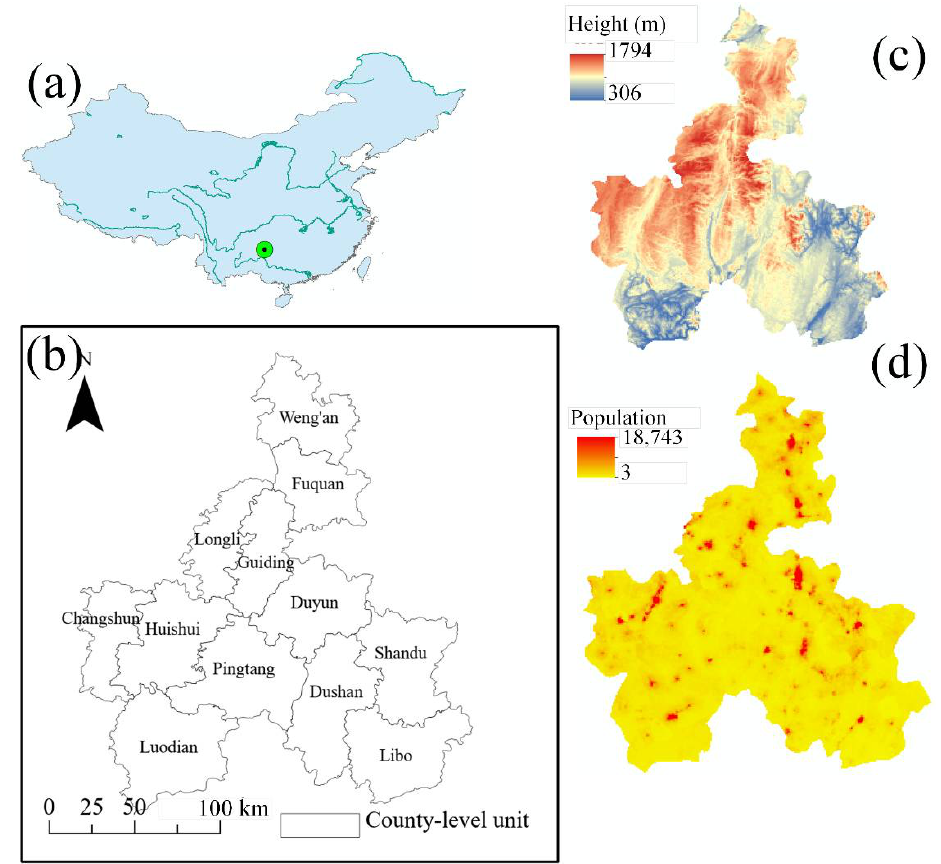
Figure 1. ( a ) Location of Qiannan in China. ( b ) Administrative division of Qiannan. ( c ) Topography of Qiannan. ( d ) Population distribution of Qiannan.